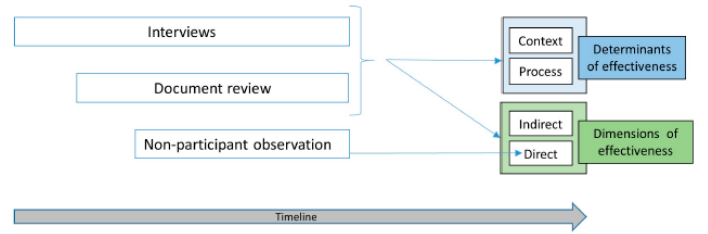
Figure 1. Diagram of the whole analysis process.